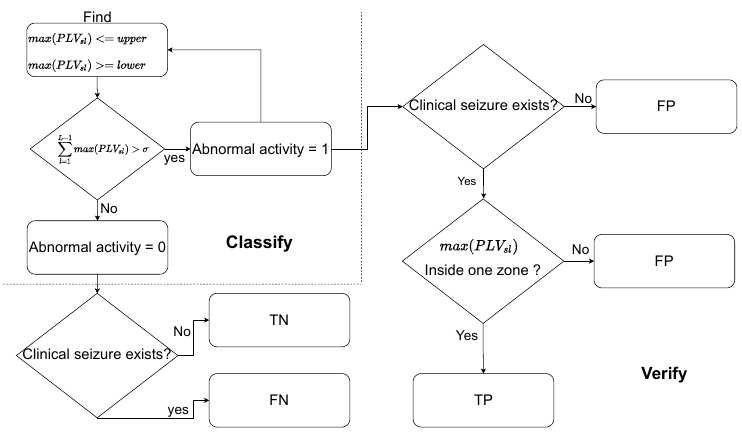
Figure 2. This figure shows an overview of the classification and verification process.